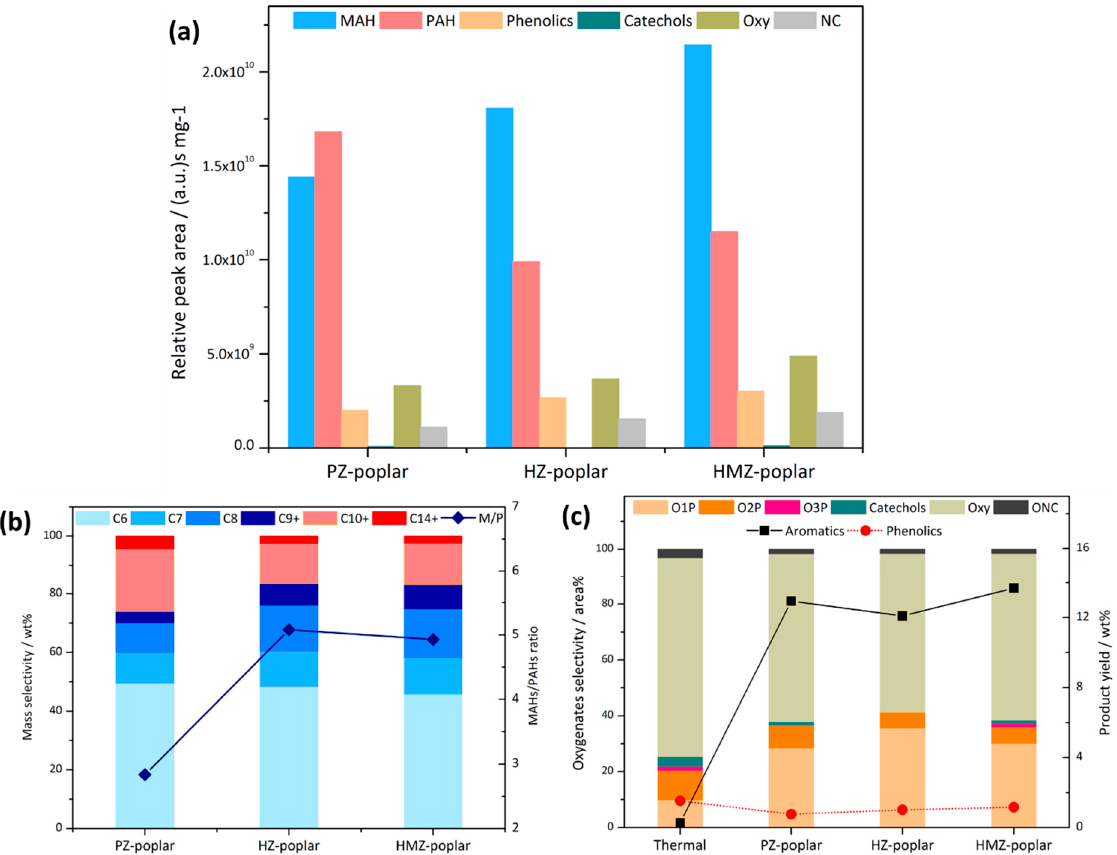
Figure 7. Product distribution of poplar sawdust. ( a ) Overall distribution based on GC–MS peak area; ( b ) mass distribution of aromatics; ( c ) relative selectivity of oxygenated products and yield of aromatics and phenolics.